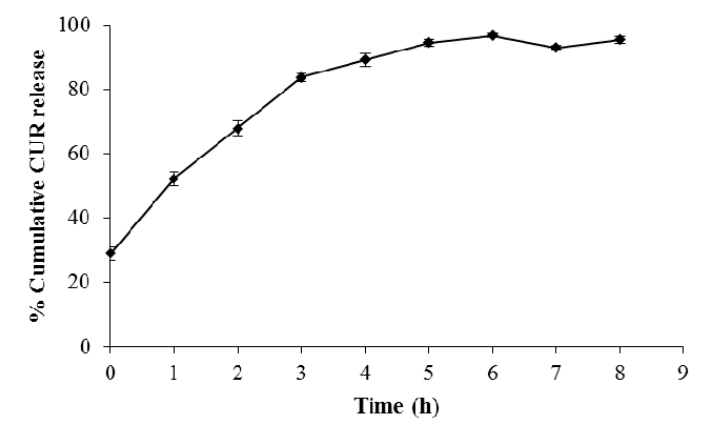
Figure 5. Release of CUR from CUR MT NPs in a simulated physiological condition. The study was performed in PBS (pH 7.4) at 37 °C for 8 h. Released CUR was separated from CUR MT NPs by Microcon-Y100 and measured by HPLC. Data are presented as the mean ± SD ( n = 3).